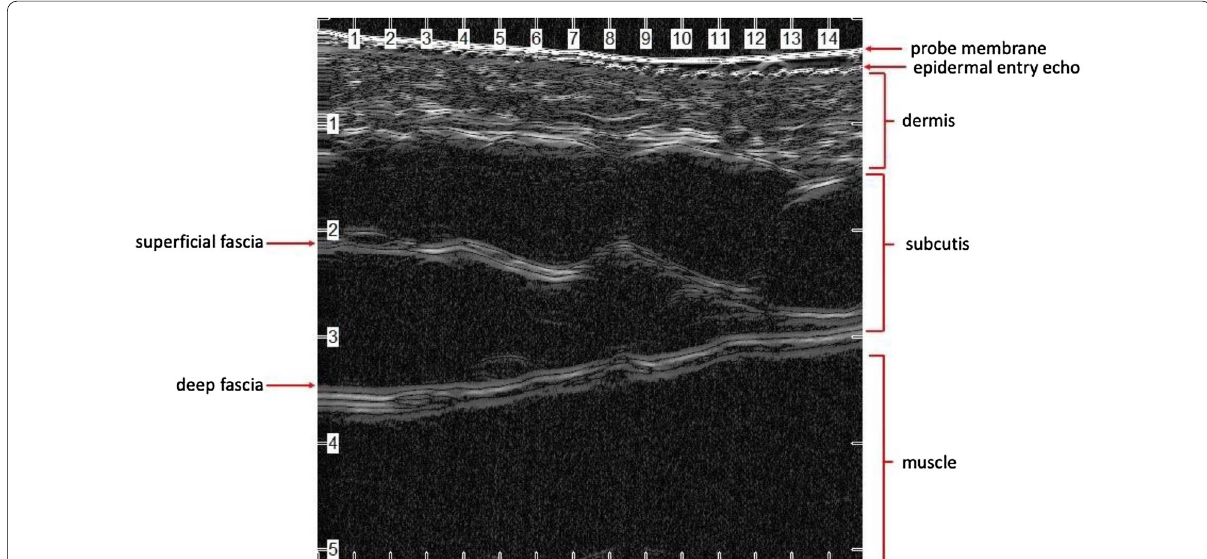
Fig. 1 Normal skin from the anterior arm using a 50-MHz HFUS probe (Longport, Inc. EPISCAN). Note the fine hyperechoic epidermal entry echo. Deep to the entry echo is the hyperechoic dermis measuring about 1 millimeter (mm) with thicker horizontal bands in the deep dermis corresponding to the organized, horizontally arrayed collagen bundles in the reticular dermis. Deep to the dermis is the subcutis composed primarily of hypoechoic fat globules. Within this layer is the hyperechoic superficial fascia. Deep to the subcutis is the hyperechoic deep fascia overlying the biceps